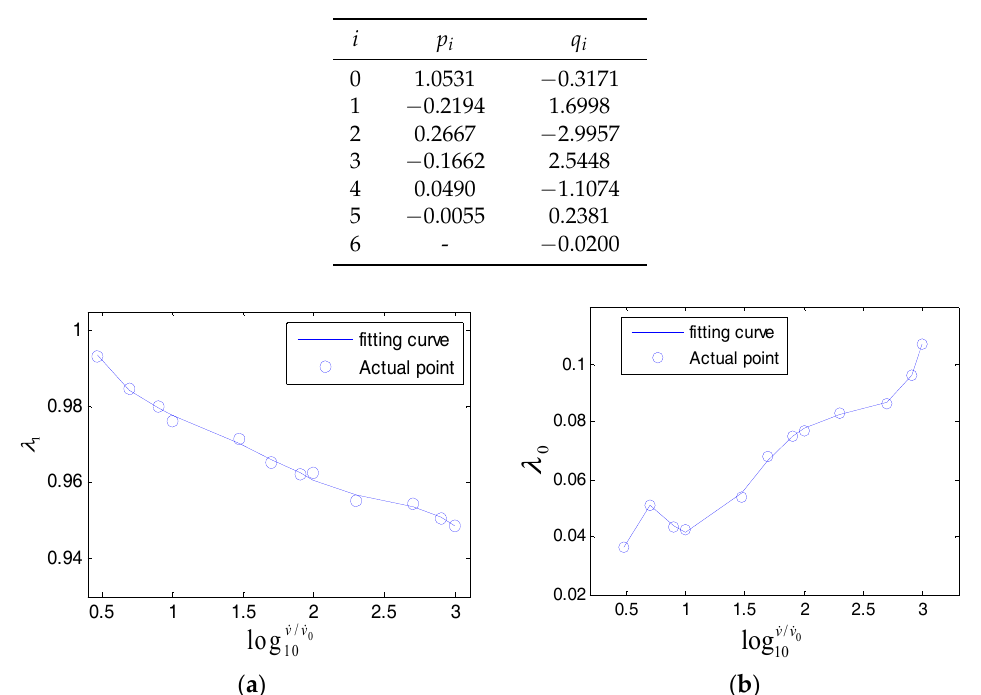
Table 6. The coefficients of polynomials for Equations (21) and (22).